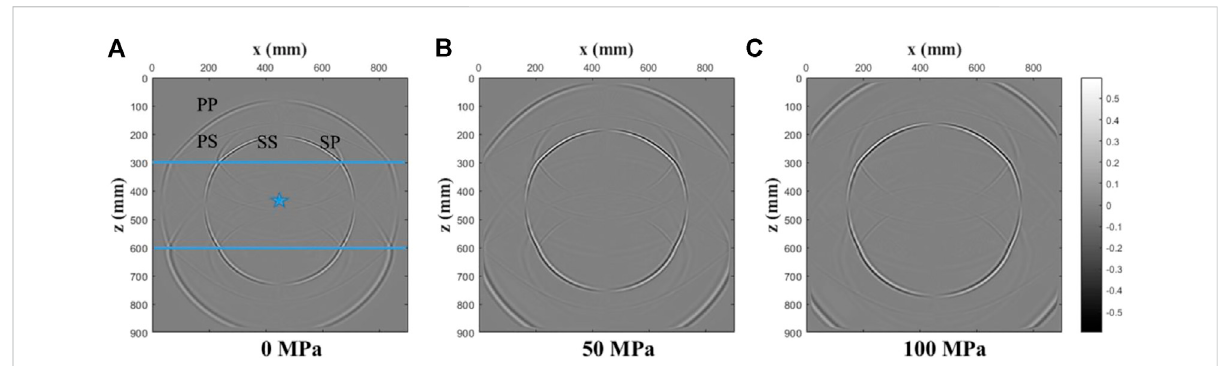
FIGURE 16 Coupled wave fi eld snapshots of the x -component at t = 0.1 ms for a three-layer model under various con fi ning stresses ( (A) : 0 MPa; (B) : 50 MPa; (C) : 100 MPa). The location of the source is marked by a star in the fi gure. The consecutive wavefronts include P-wave (P), S-wave (S), P-wave transmission (PP), S-wave transmission (SS), S-wave converted by P-wave (PS), and P-wave converted by S-wave